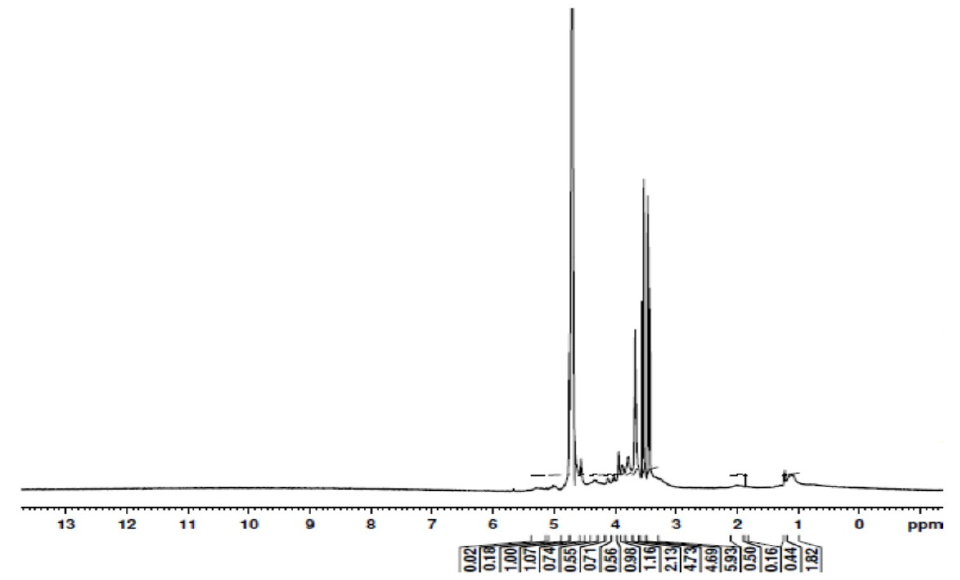
Figure 5. H 1 NMR of fucoidan from the brown seaweed Sargassum ilicifollium .